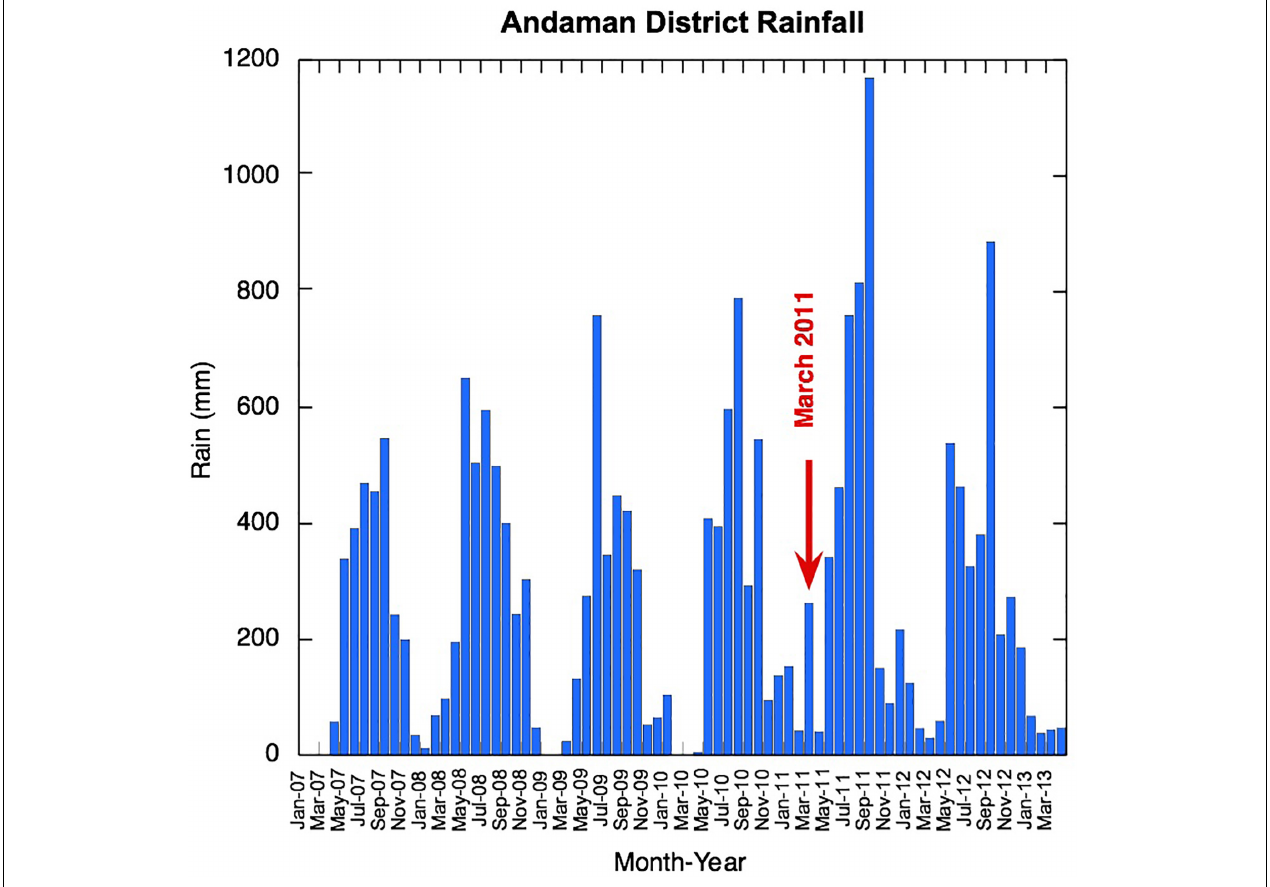
FIGURE 3 | Andaman Island district monthly rainfall before and during sampling (data from India Meteorological Department Hydromet division